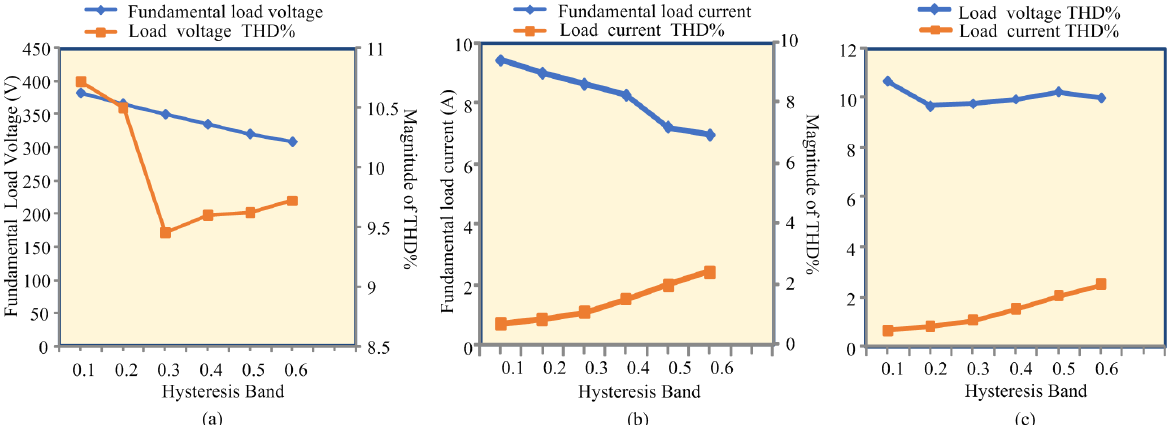
Figure 10. Variation in ( a ) fundamental voltage and its THD, ( b ) fundamental current and its THD, and ( c ) voltage and current